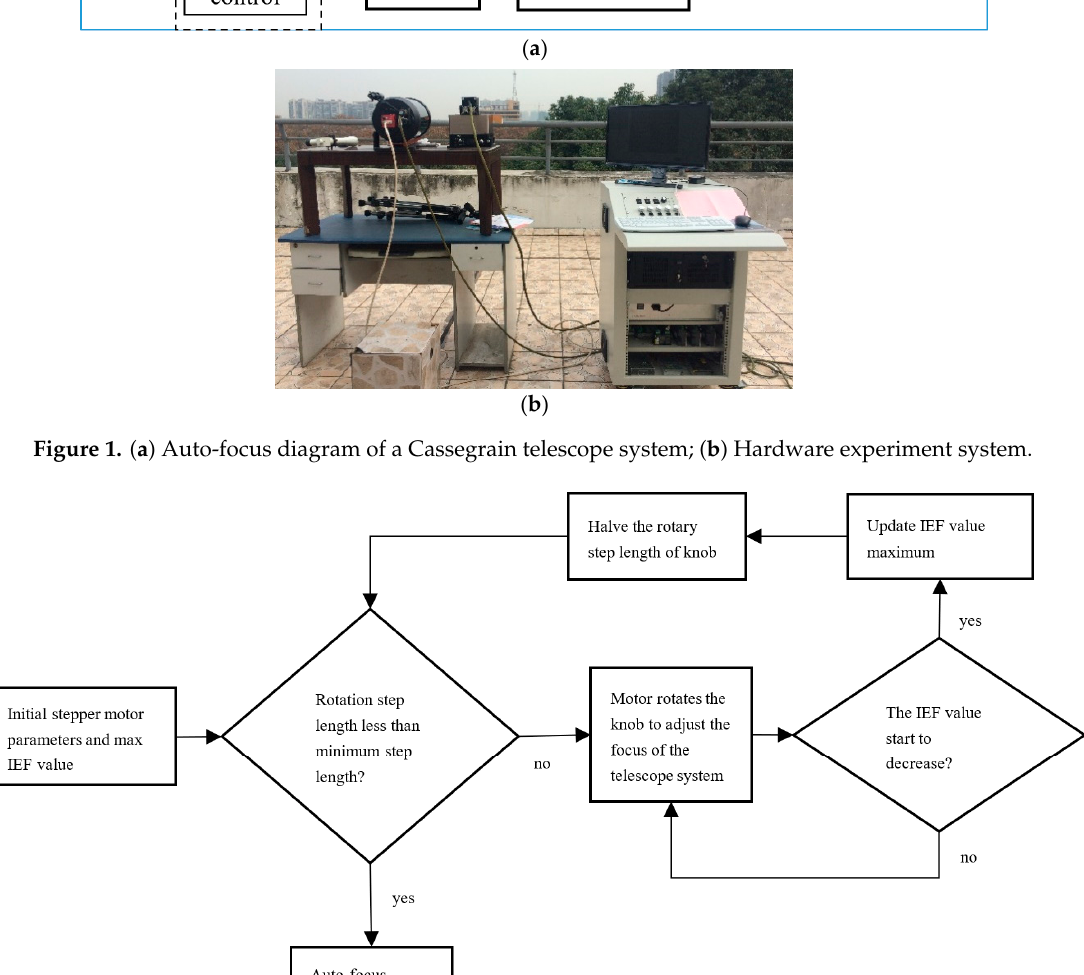
Figure 1. ( a ) Auto-focus diagram of a Cassegrain telescope system; ( b ) Hardware experiment system.